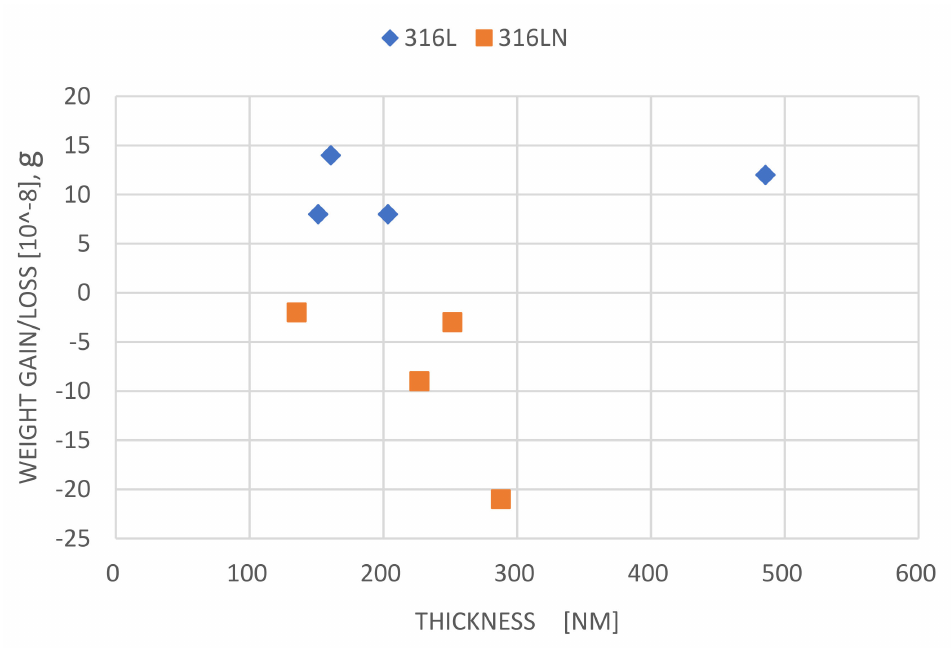
Figure 13. Relation between oxide film thickness and oxidation weight gain/loss obtained under irradiation condition by using a plate type